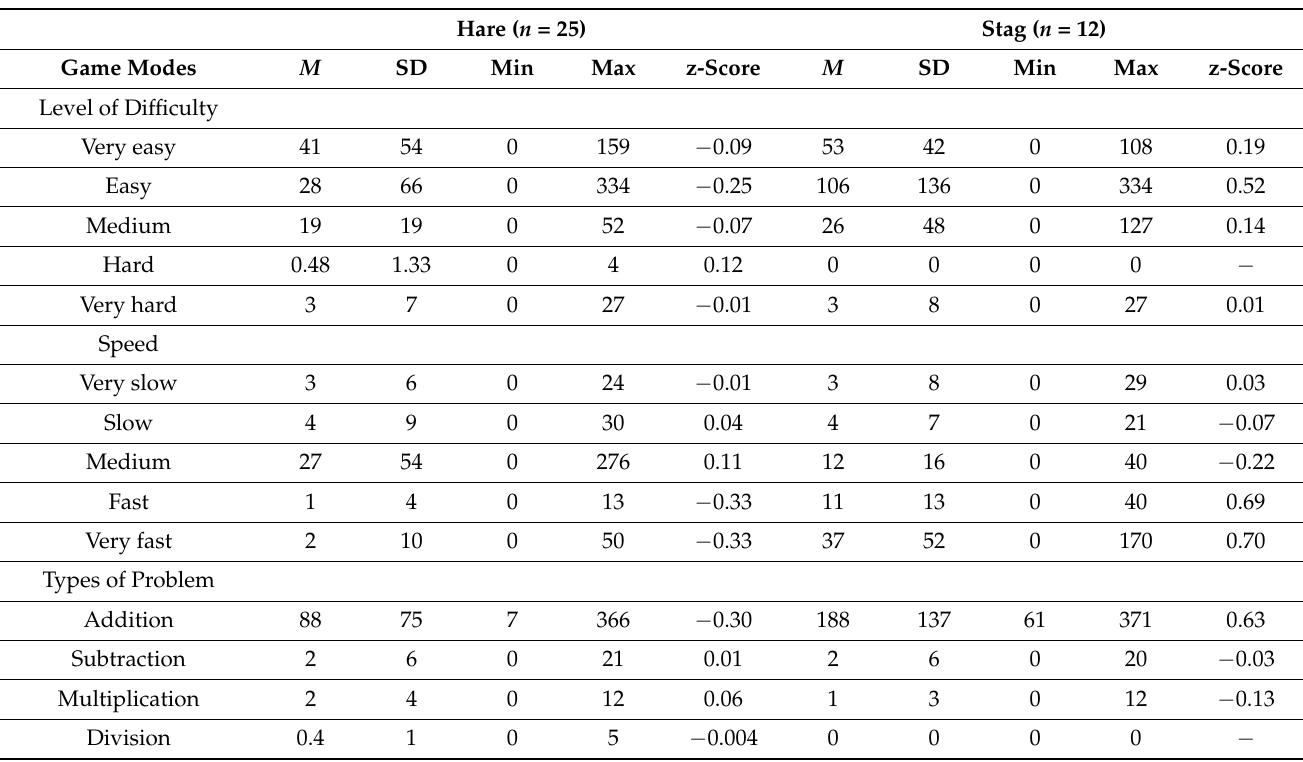
Table 4. The frequencies of game mode settings were standardized by using z-scores. Hare hunters solved a more diverse range of arithmetic problems, while stag hunters were more inclined to solve addition problems.